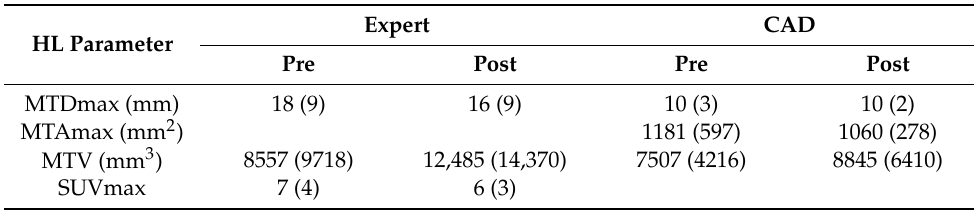
Table 1. Average PET metabolic parameter measurements and standard deviations (in parentheses) pre and post treatment for the HL cases.